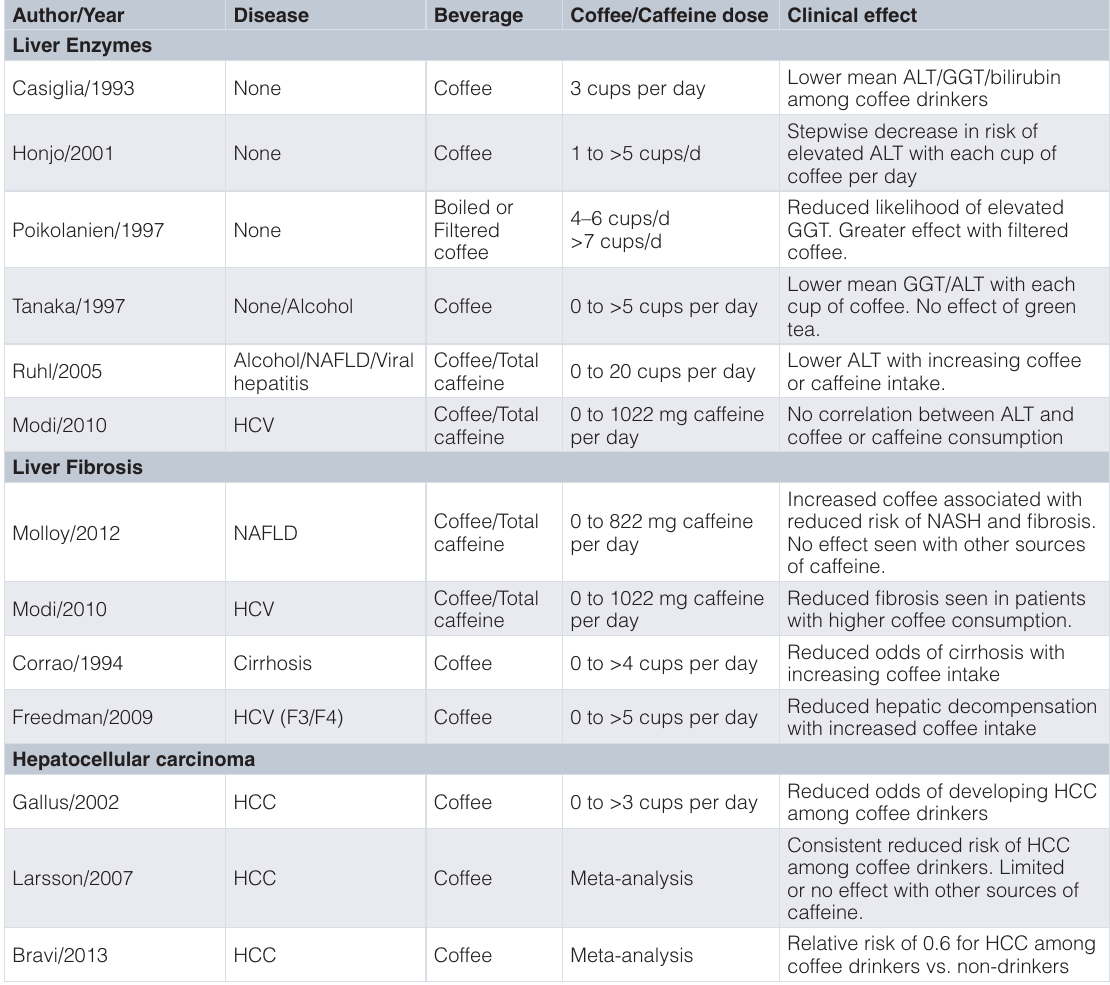
Table 1. Summary of scientific papers examining effects of coffee on human liver injury, fibrosis, and HCC.